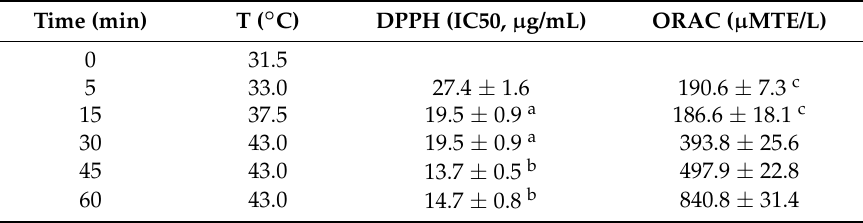
Table 2. DPPH and ORAC antioxidant activities, with the respective standard deviations, for test SFN_T2 (Silver Fir Needles—Test 2). Superscripts, in any column, indicate indistinguishable values ( p >